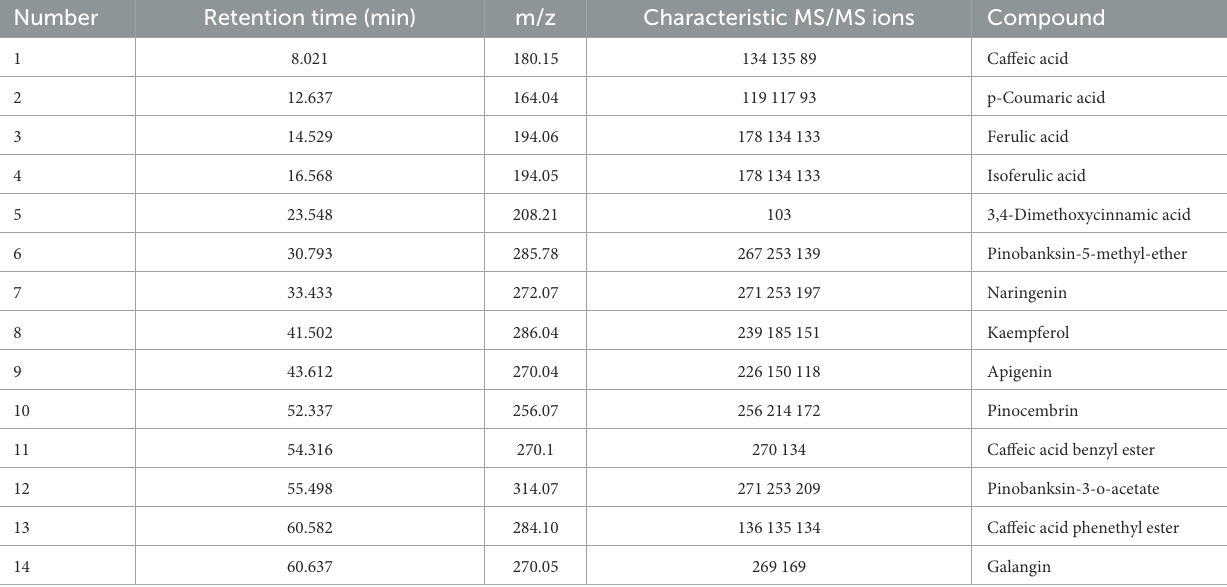
TABLE 2 Ion fragment parameters of propolis